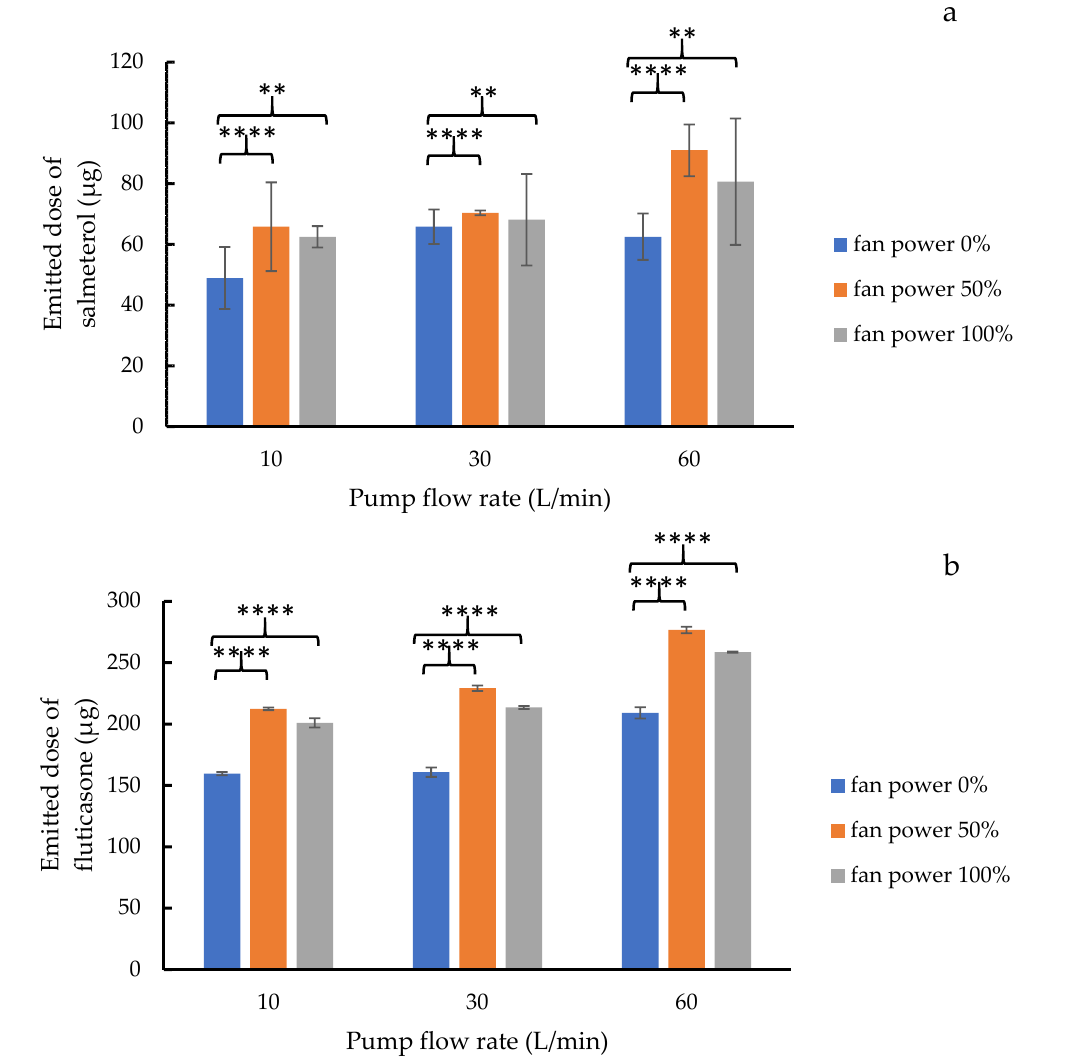
Figure 8. Relation between the fan motor power and emitted dose of ( a ) salmeterol xinafoate and ( b ) fluticasone propionate from a DPI attached with the add-on equipment. Statistical analysis was performed using an ordinary two-way ANOVA and comparing 0% fan power only at each pump flow rate with 50–100% fan power for emitted dose uniformity. (** p -value < 0.01, **** p -value < 0.0001).